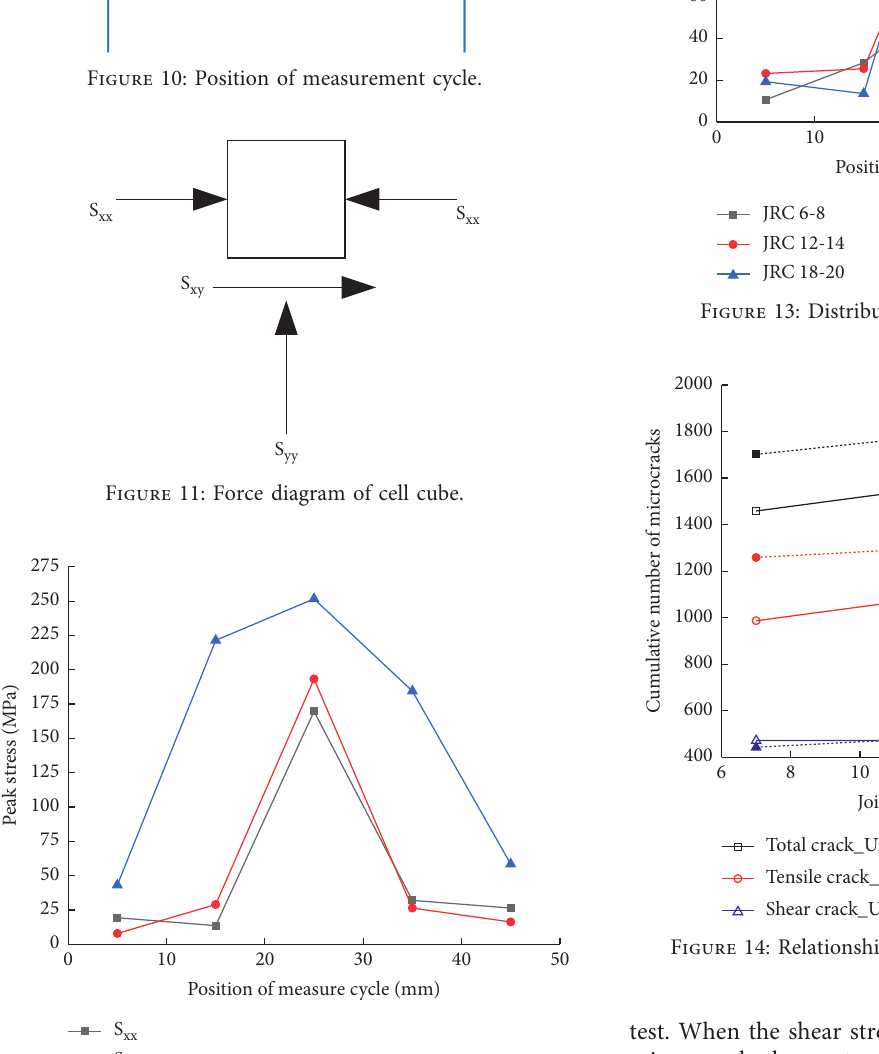
Figure 12: Distribution curves of stress on the bolt.